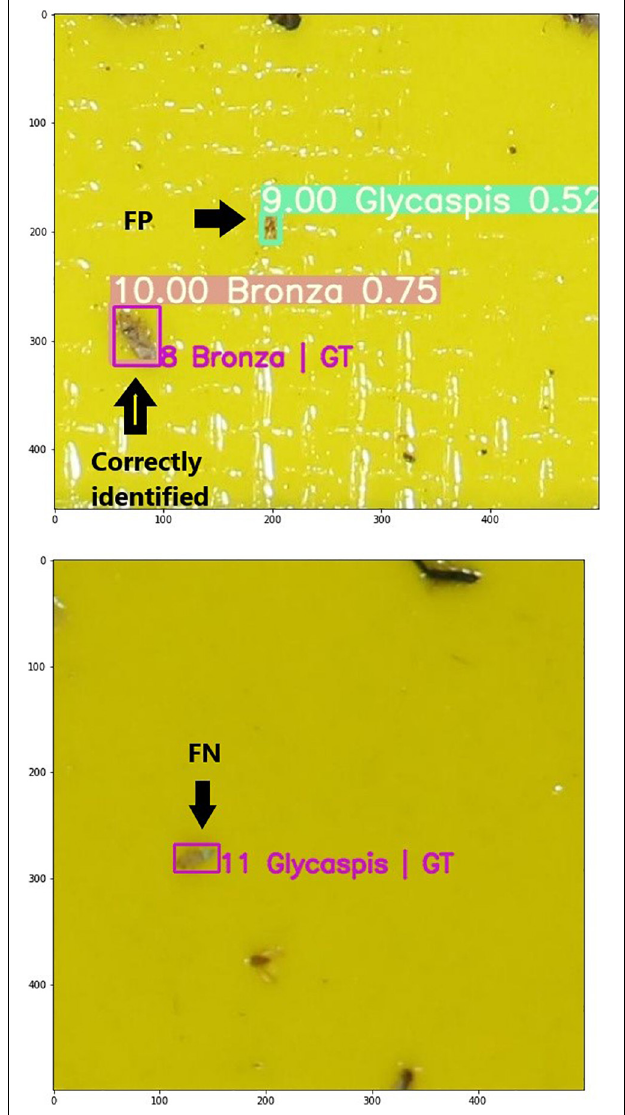
FIGURE 3 | Two images from the test set with ground truth (GT, magenta) bounding boxes, and predicted ones (green). Each box is labeled by its class. The predicted boxes are also annotated by a confidence score. The top image demonstrates a correct identification of a bronze bug (true positive), and a false positive prediction of a Glycaspis psyllid. The bottom image demonstrates a false negative result, namely a Glycaspis individual annotated by the human expert but not detected with the machine-learning